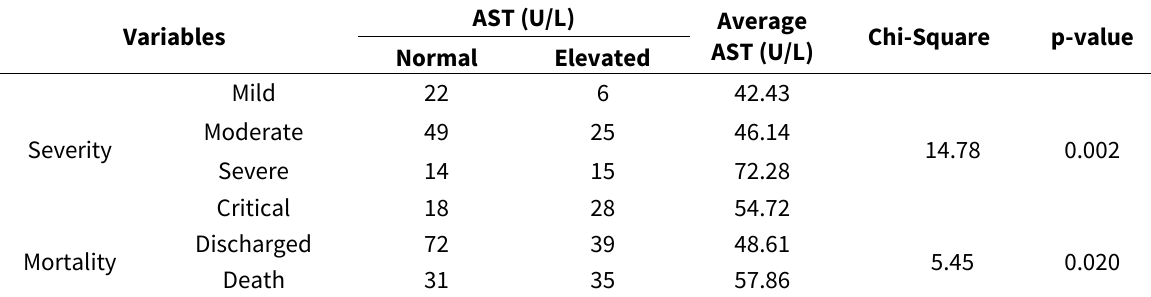
Table 3 . Relationship of Increased ALT on Severity and Mortality.